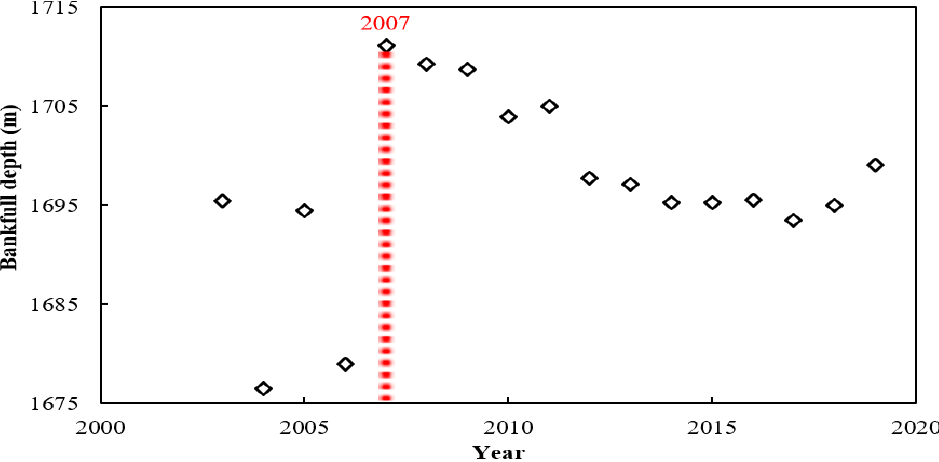
Figure 6. Variations in the Bankfull depth in the Wuhan reach.